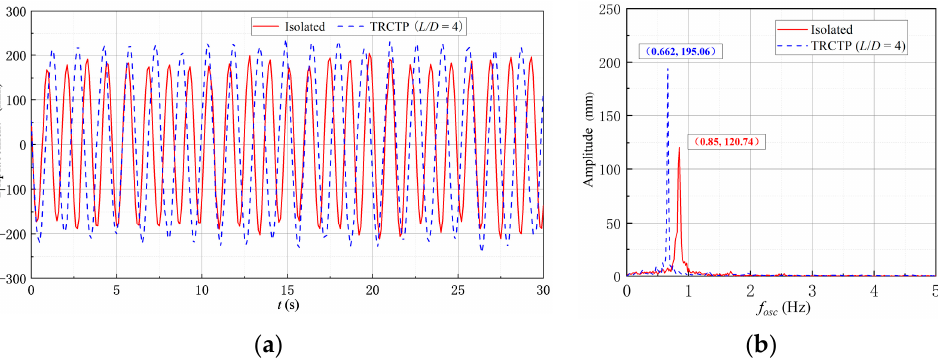
Figure 16. Typical displacement and spectra at U r = 11 ( L / D = 4). ( a ) Comparison of displacement time history; ( b ) Comparison of spectra.